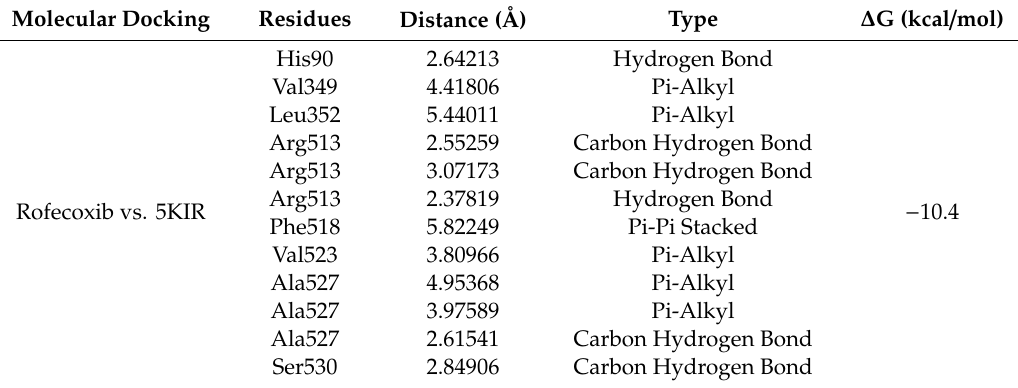
Table 3. Type of interactions and interacting residues of h COX-2 and rofecoxib. Molecular Docking